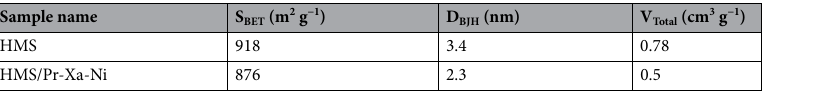
Table 1. Textural properties of HMS and catalyst obtained by nitrogen adsorption/desorption